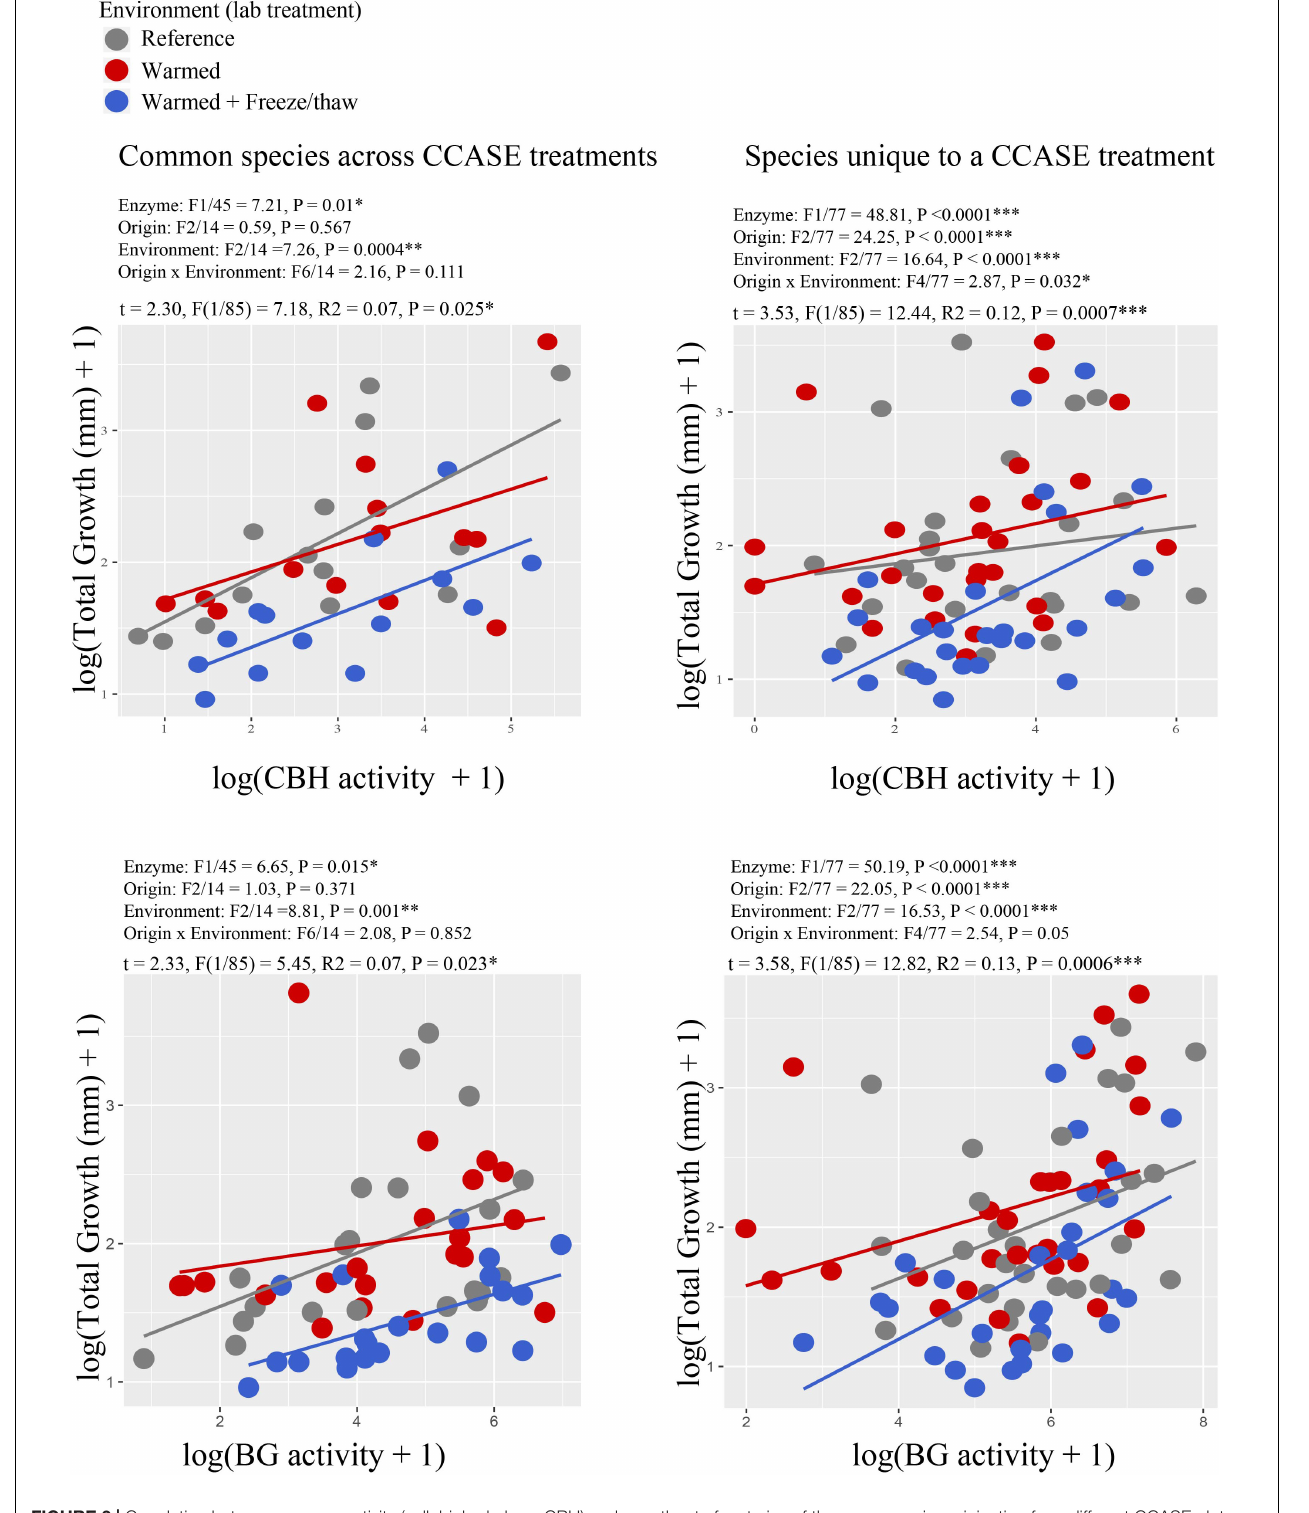
FIGURE 3 | Correlation between enzyme activity (cellobiohydrolase, CBH) and growth rate for strains of the same species originating from different CCASE plots. Points are color-coded by laboratory environment in the common garden experiment. Other enzymes also correlated with growth rate, including β -Glucosidase (BG) (common species: R2 = 0.21, P = 0.001, uncommon species: R2 = 0.08, P = 0.003). Enzyme activities are reported in units of nmol substrate h − 1 mg biomass − 1 .